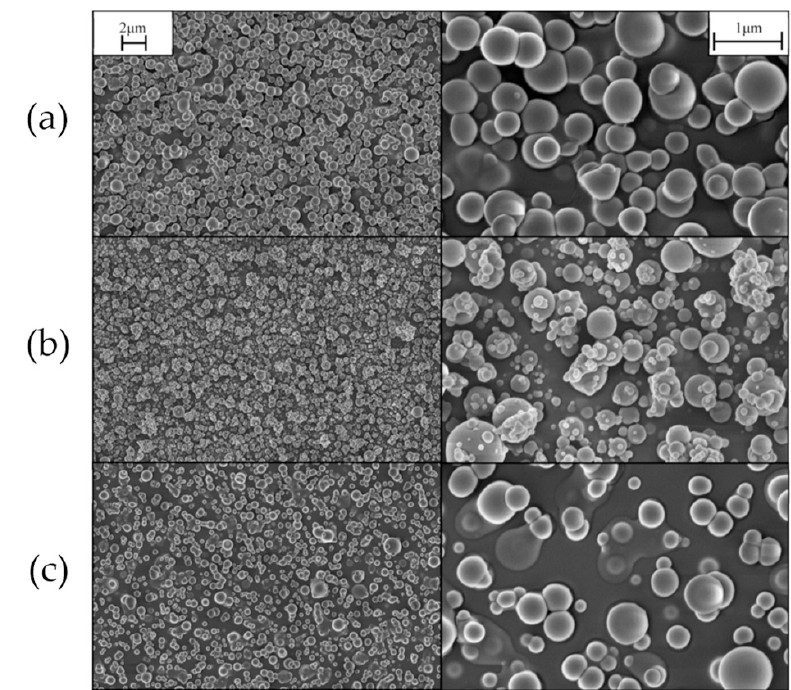
Figure 9. SEM images (at a magnification of 10k×, left and 50k×, right) of gentamicin-loaded NC coatings deposited for 20 min in a parallel-plate DBD fed with helium, ethylene, and an aqueous gentamicin solution (10 mg/mL). The DBD is generated using different electrical excitation conditions: ( a ) continuous mode, high power; ( b ) pulsed mode, high power; ( c ) continuous mode, low power. Reproduced with permission from [148].